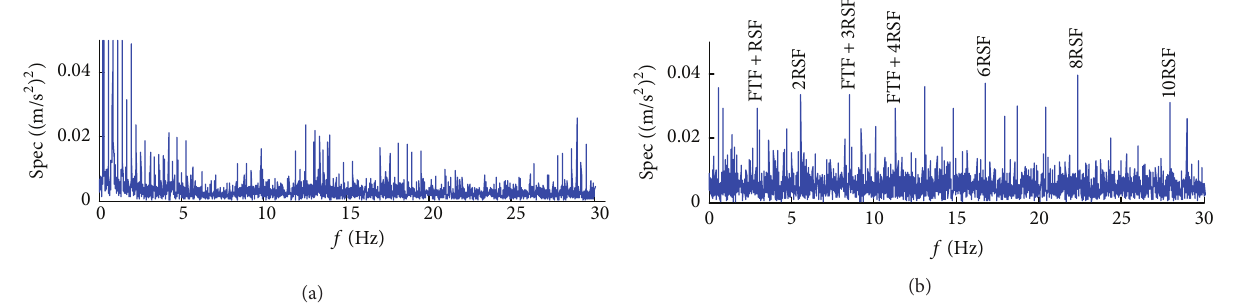
Figure 15: Slices of the MuSEnS at scale 35 in chn08 and chf08. (a) Normal and (b)